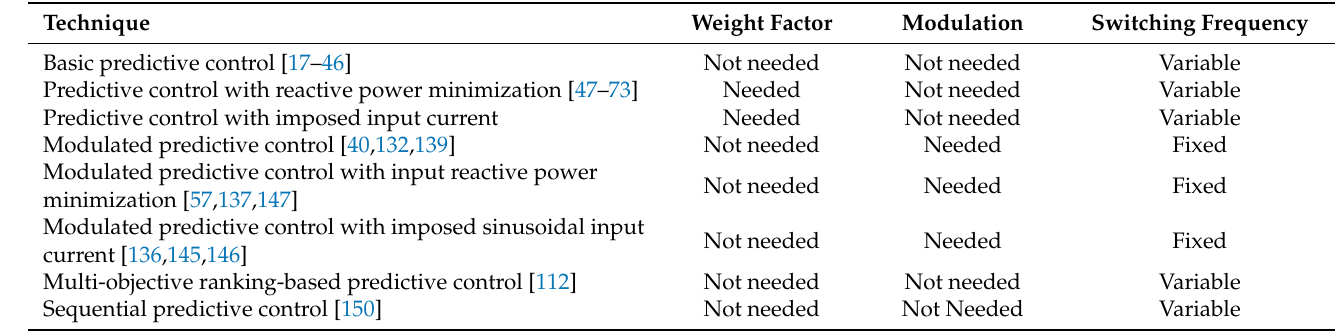
Table 4. Comparison of new trends based on predictive control and classical